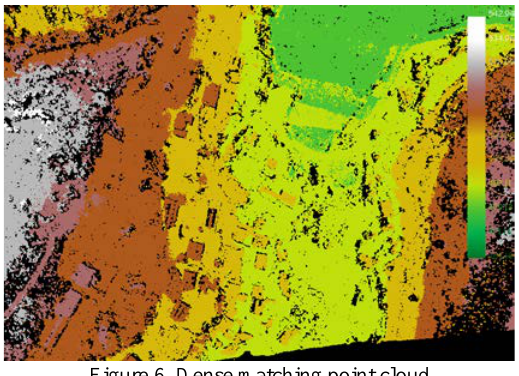
Figure 6. Dense matching point cloud